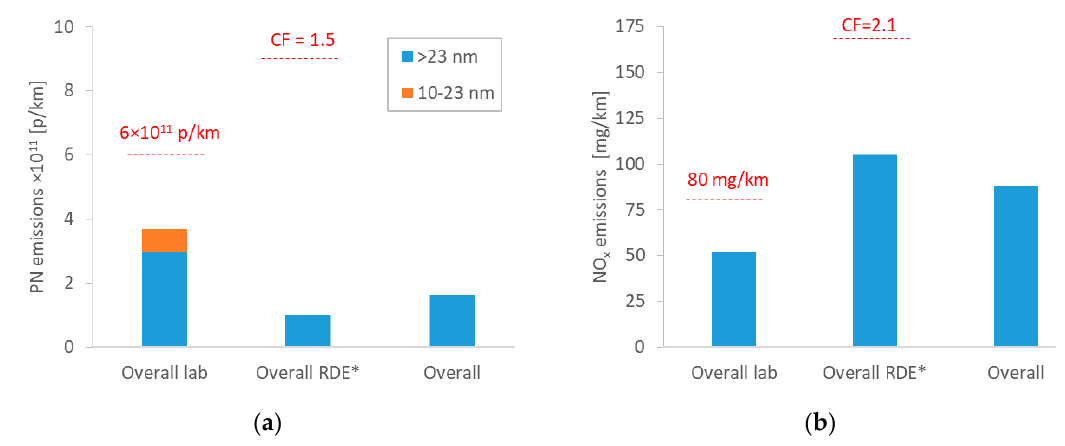
Figure 11. Weighted emissions (including regenerations): ( a ) Particle Number (PN); ( b ) NO x . RDE* refers to a mix of Real-Driving Emissions (RDE)-compliant and non-compliant routes.